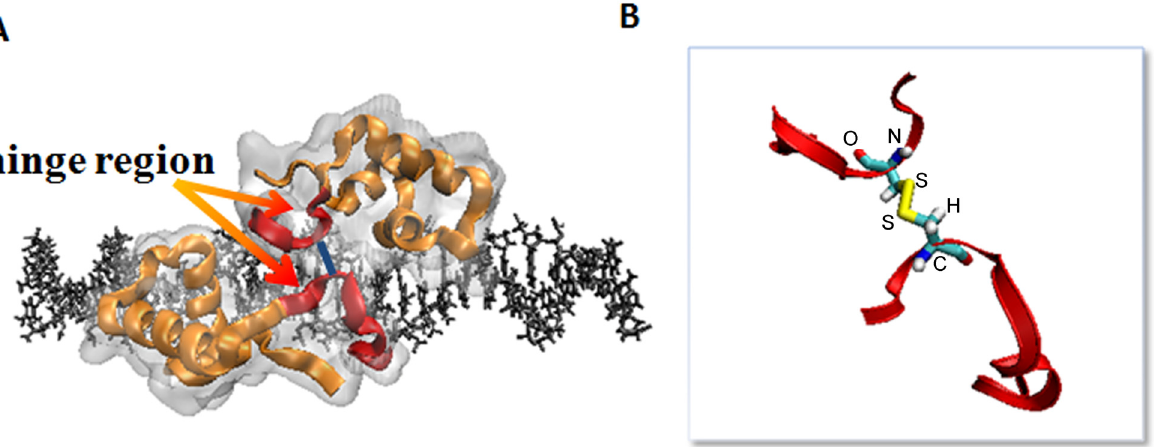
Fig 1. The conformation of the nonspecific LacI Δ 1-62/DNA system. (A) The LacI Δ 1 – 62 is composed of two monomers, which are connected by an S-S bond in the residue CYS52 (blue line). (B) explicitly represents the S-S bridge. The DNA-binding domain of LacI Δ 1 – 49 is shown as orange ribbons; The hinge region of LacI Δ 50 – 62 is shown as red ribbons; The residue CYS52 is shown in Licorice representation; S atoms are in yellow, O atoms are in red, N atoms are in blue, C atoms are in cyan, and H atoms are in